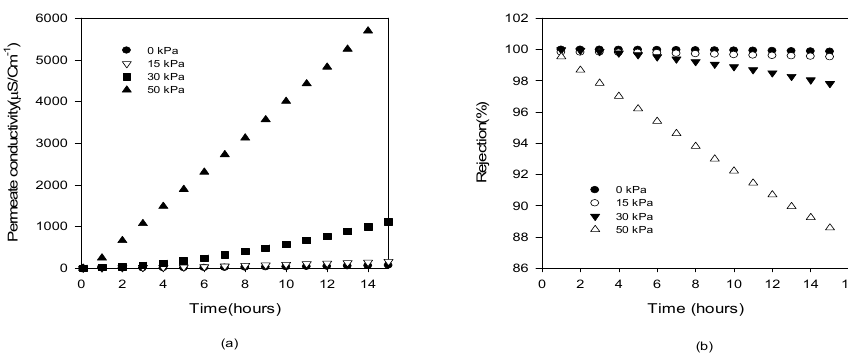
Figure 9. Dependence of distillate conductivity and solute rejection on time under various applied pressures ( Δ p ) ( a ) distillate conductivity ( b ) solute rejection.